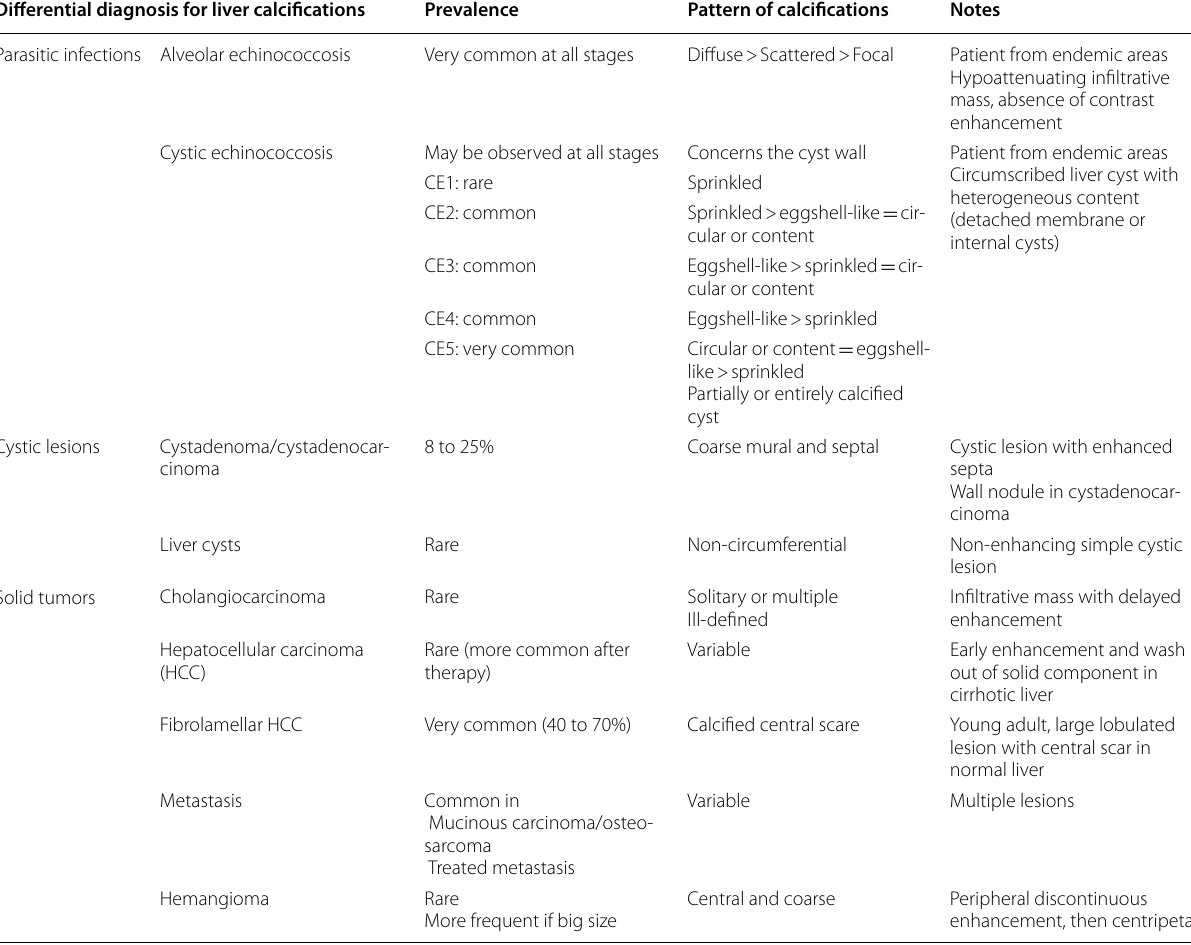
Table 2 Differential diagnosis for liver calcifications Differential diagnosis for liver calcifications